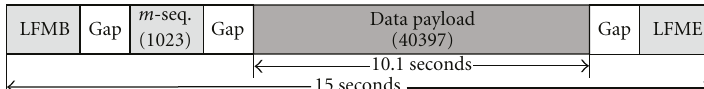
Figure 11: SIMO packet structure in Unet06 experiment.